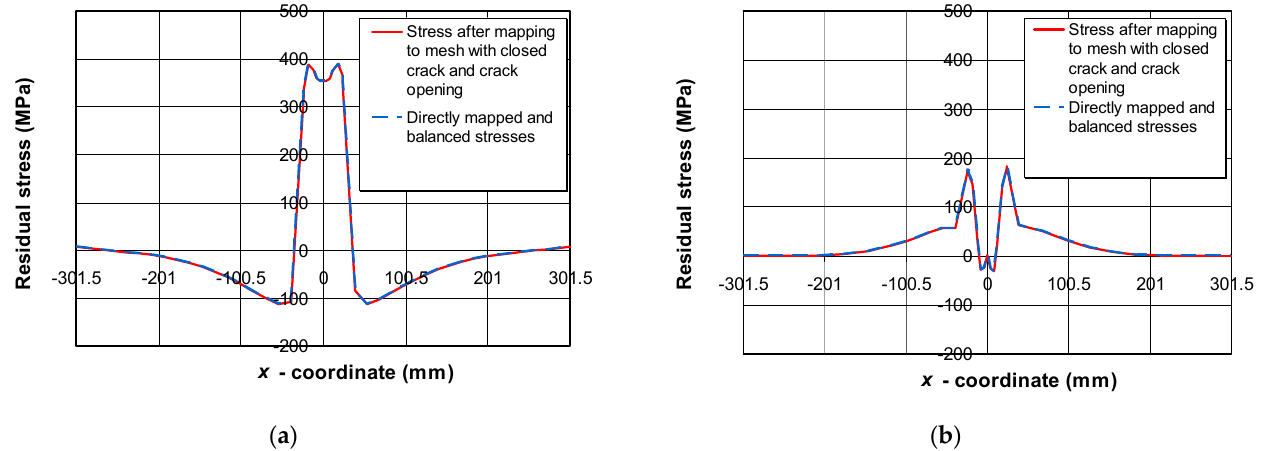
Figure 7. Residual stresses after stress balancing in a plate with a crack: ( a ) longitudinal stress, ( b ) transversal stress. The stresses are computed at the bottom plate surface along line A-A, as shown in Figure 1.